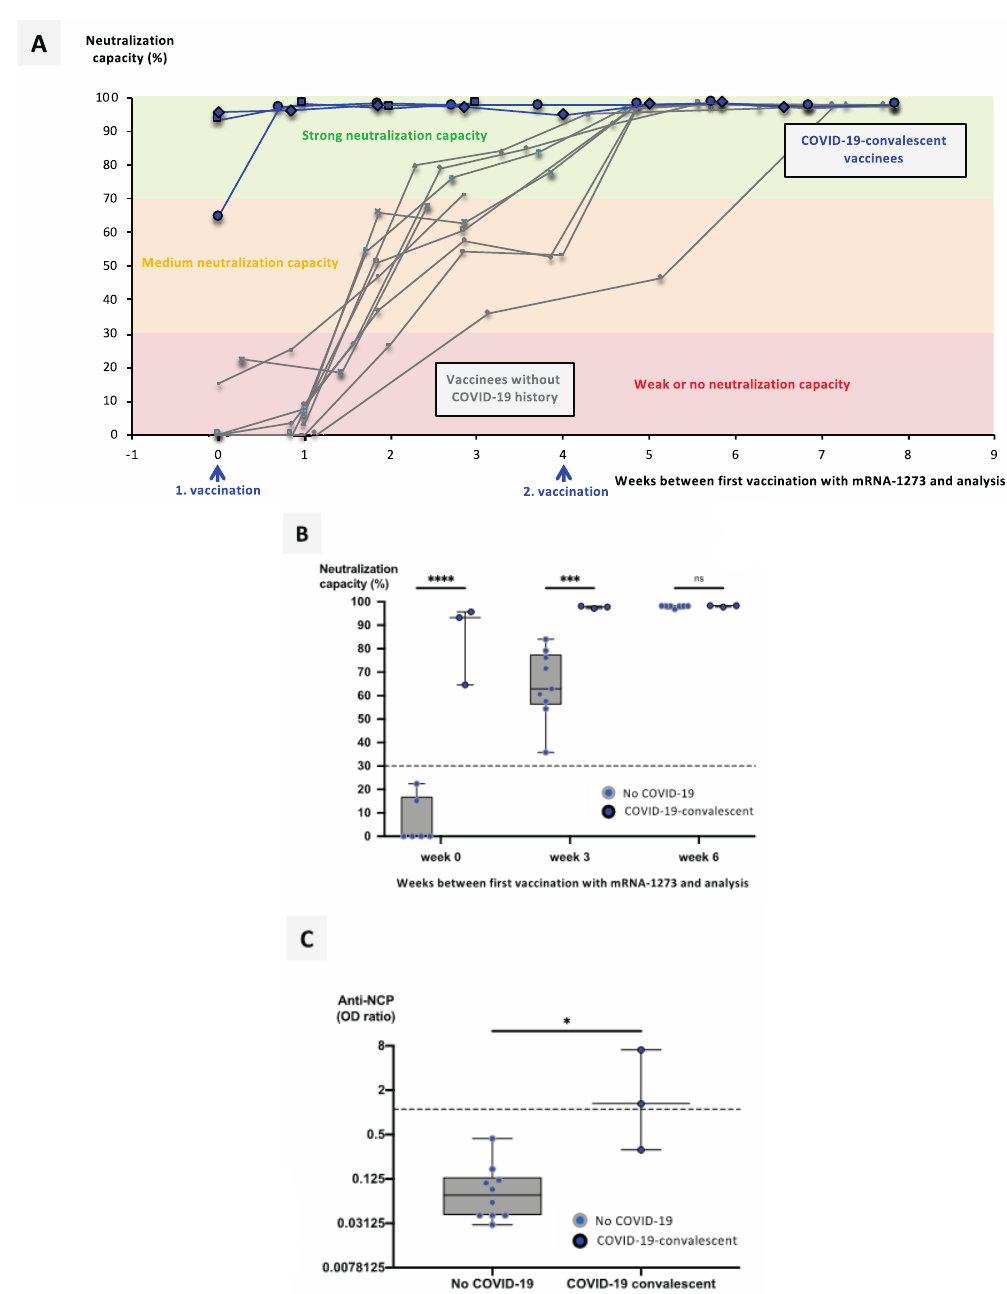
Figure 3. Impact of a previous SARS-CoV-2 infection on the neutralizing immune response to vaccination with mRNA-1273. Serum samples from 10 mRNA-1273-vaccinated individuals without history of COVID-19 and 3 COVID-19-reconvalescent mRNA-1273-vaccinated individuals were collected at different timepoints after their first vaccination, as indicated. ( A ) Line graphs show individual courses for the neutralization capacity of ACE2–RBD interaction. ( B ) Boxplots show median neutralization capacities at the time of first vaccination (0 weeks), as well as 3 weeks and 6 weeks after first vaccination. ( C ) Boxplots show median anti-NCP IgG titers for COVID-19-negative versus COVID-19-convalescent donors. Box central horizontal lines indicate medians, box borders represent IQR, and whiskers indicate minima and maxima. For statistics, Š í d á k’s test for multiple comparisons ( B ) and the Mann–Whitney U test ( C ) were used. Significance levels were * p < 0.05, *** p < 0.0005, and **** p < 0.00005. Abbreviations: COVID-19: coronavirus disease 2019; ACE2: angiotensin-converting enzyme 2; RBD: receptor-binding domain; IQR: interquartile range; n.s.: not